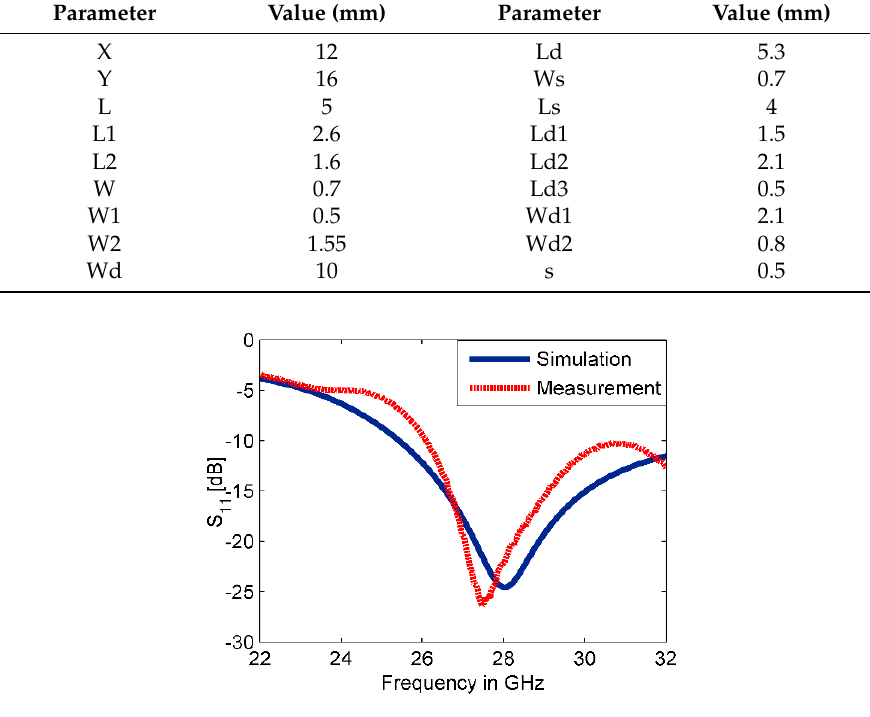
Figure 5. The proposed dipole ( a , b ) the front and back views of the designed configuration and ( c , d ) the front and back views of the fabricated prototype. Table 1. Geometric specifications of the printed dipole antenna.